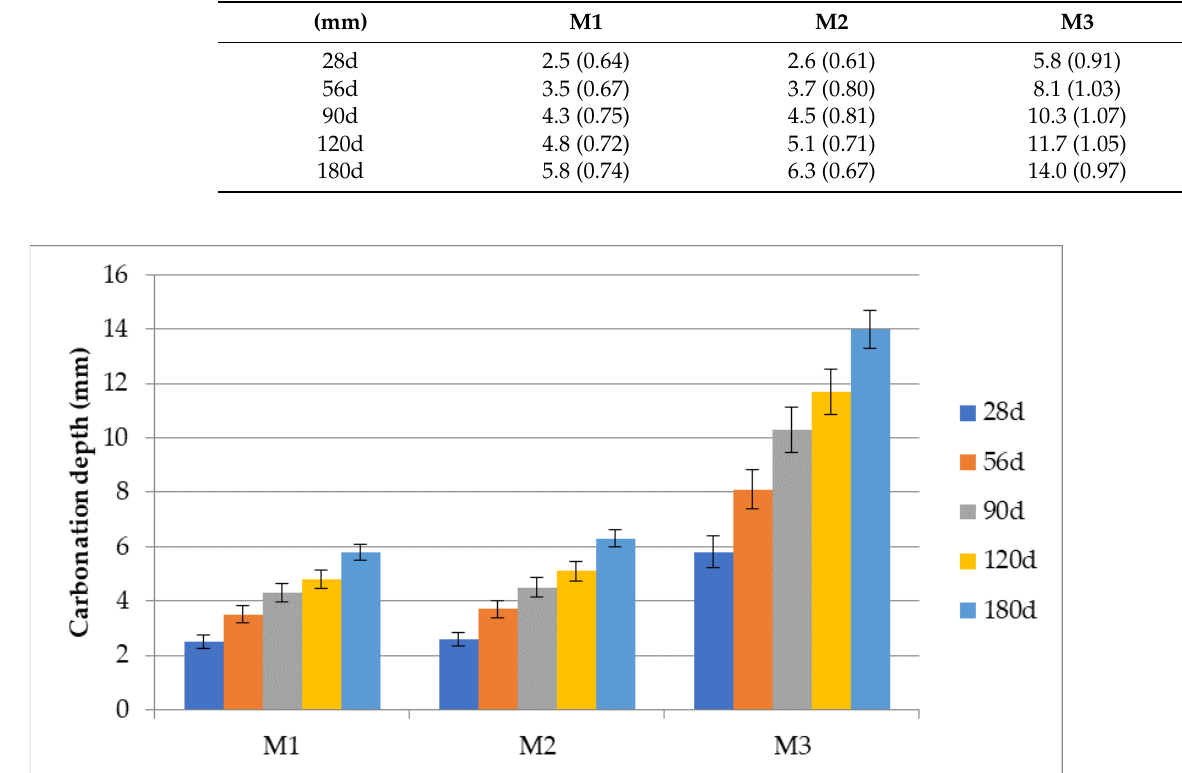
Figure 7. Accelerated carbonation depth of cement mortars.